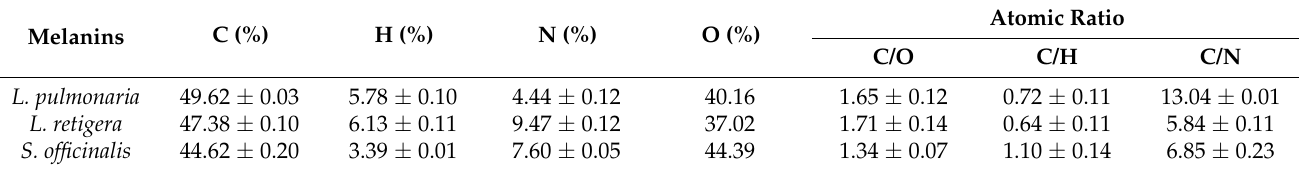
Table 1. The element content of C, H, N, O and atomic ratio in the